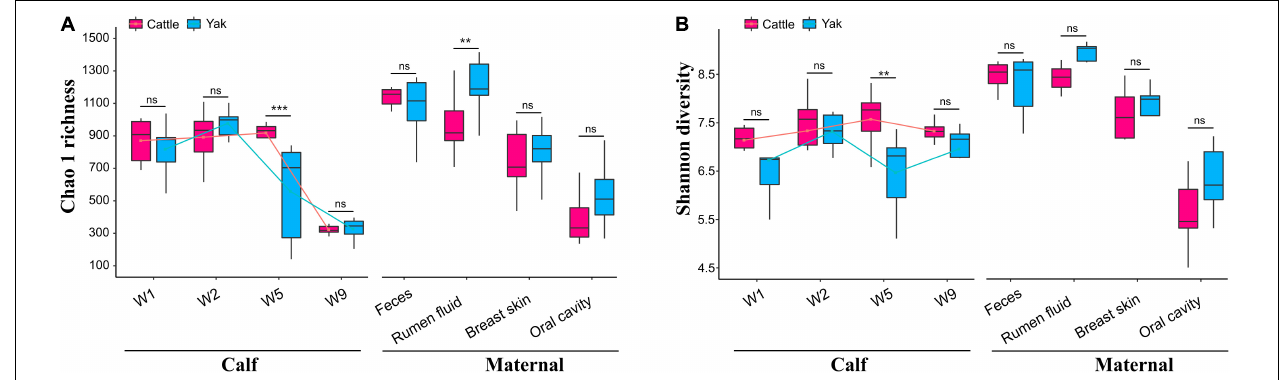
FIGURE 2 | Richness and diversity of the calf and maternal microbiota. (A) The Chao1 species richness and (B) Shannon diversity indexes of microbial communities in the samples of yak and cattle calf feces, and their mothers. W1, W2, W5, and W9 represent fecal samples from calves at weeks 1, 2, 5, and 9 after birth. The lines in the box plot show the trend of microbial community diversity in the feces of yak and cattle calves at different weeks after birth. Statistical differences were analyzed using the Wilcoxon tests: *** P < 0.001, ** P < 0.01, and ns denotes a non-significant